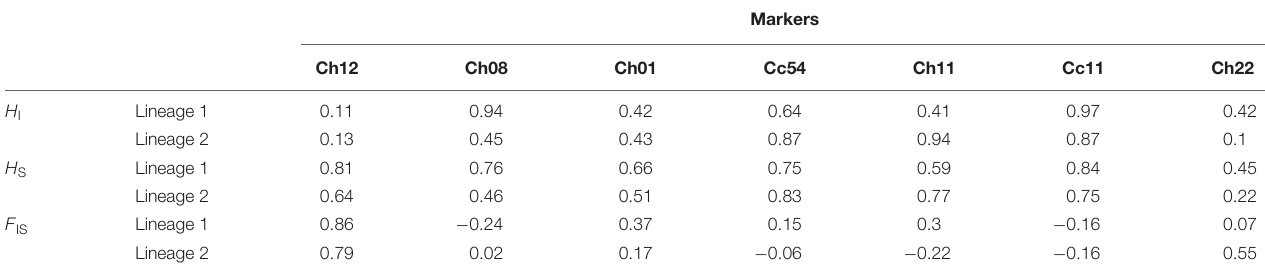
TABLE 1 | Individual heterozygosity ( H I ), population heterozygosity ( H S ) and individual inbreeding coefficient ( F IS ) of queens from hybridogenetic lineages of C. mauritanica .